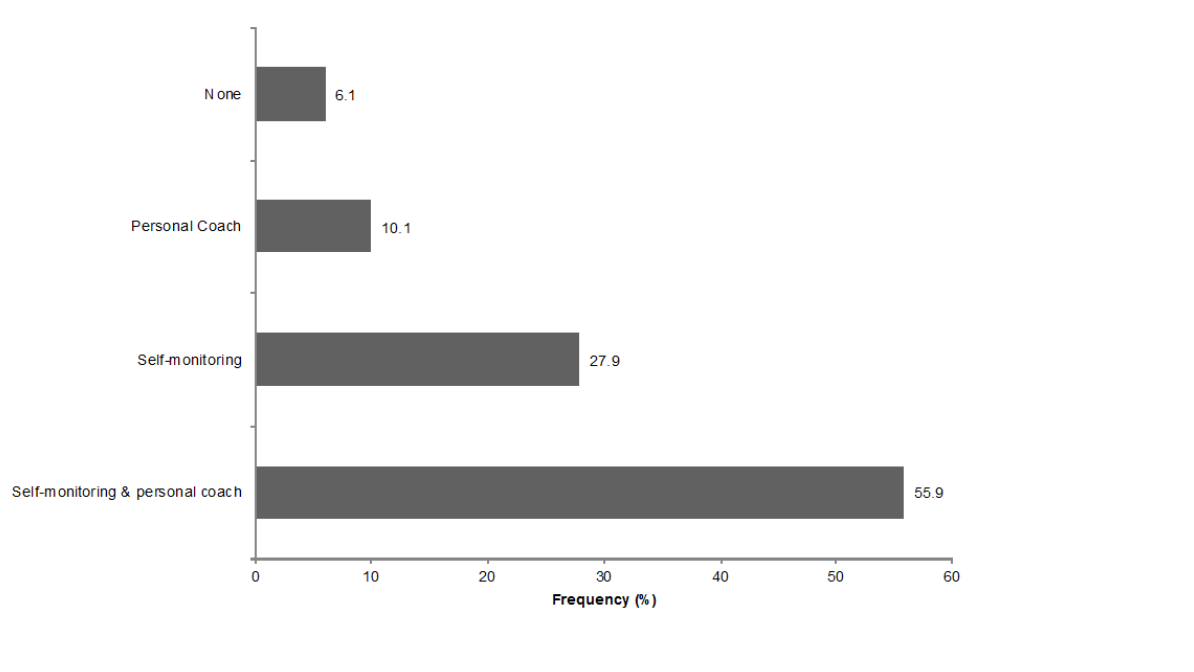
Figure 2. Physical activity app functionalities desired by